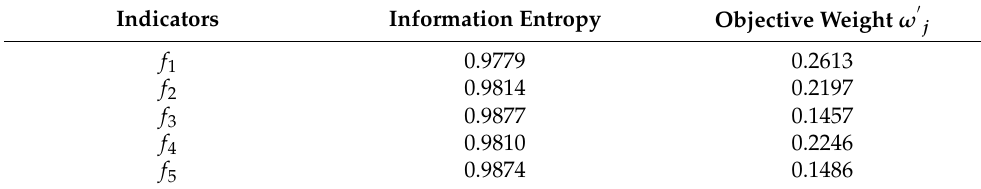
Table 6. Objective weight of each index.